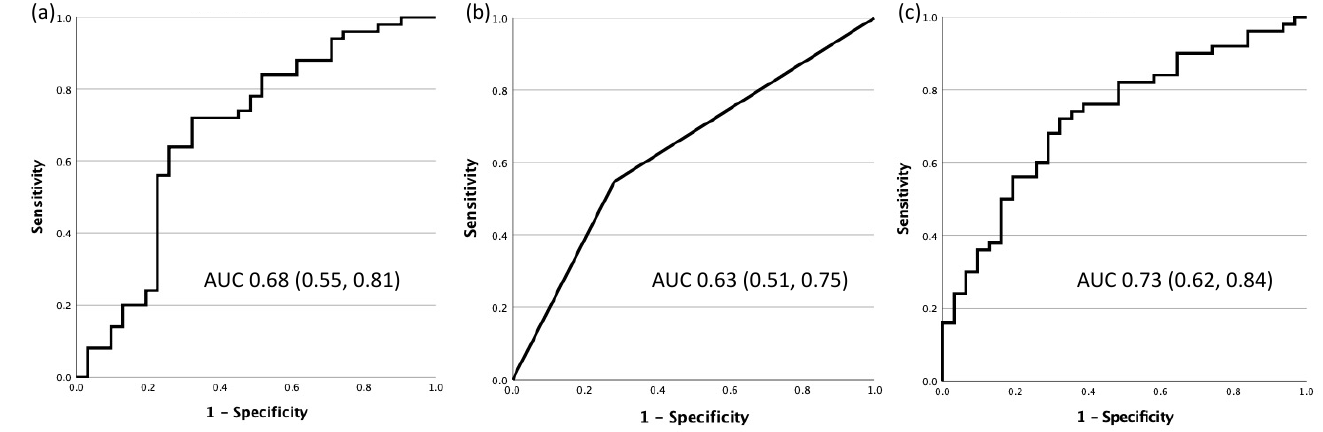
Figure 1. Area under the receiver operator characteristic curves for the prediction of screening high- risk for lifetime cardiovascular disease at 6 months postpartum by ( a ) maternal age, gestational weight gain, blood pressure at delivery, and gestational age at delivery, ( b ) maternal vascular malperfusion severity score, and ( c ) maternal vascular malperfusion severity score, maternal age, gestational weight gain, blood pressure at delivery, and gestational age at